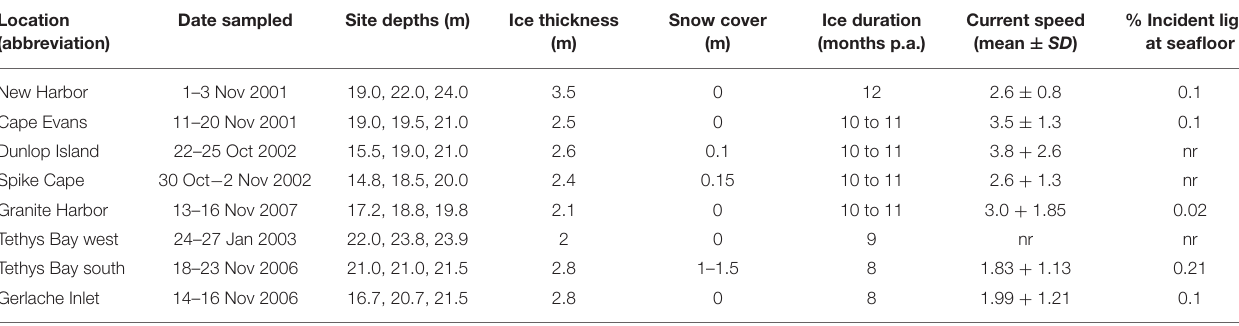
TABLE 1 | Depths, dates of sampling, and broad scale environmental characteristics at the eight coastal Ross Sea locations. Location